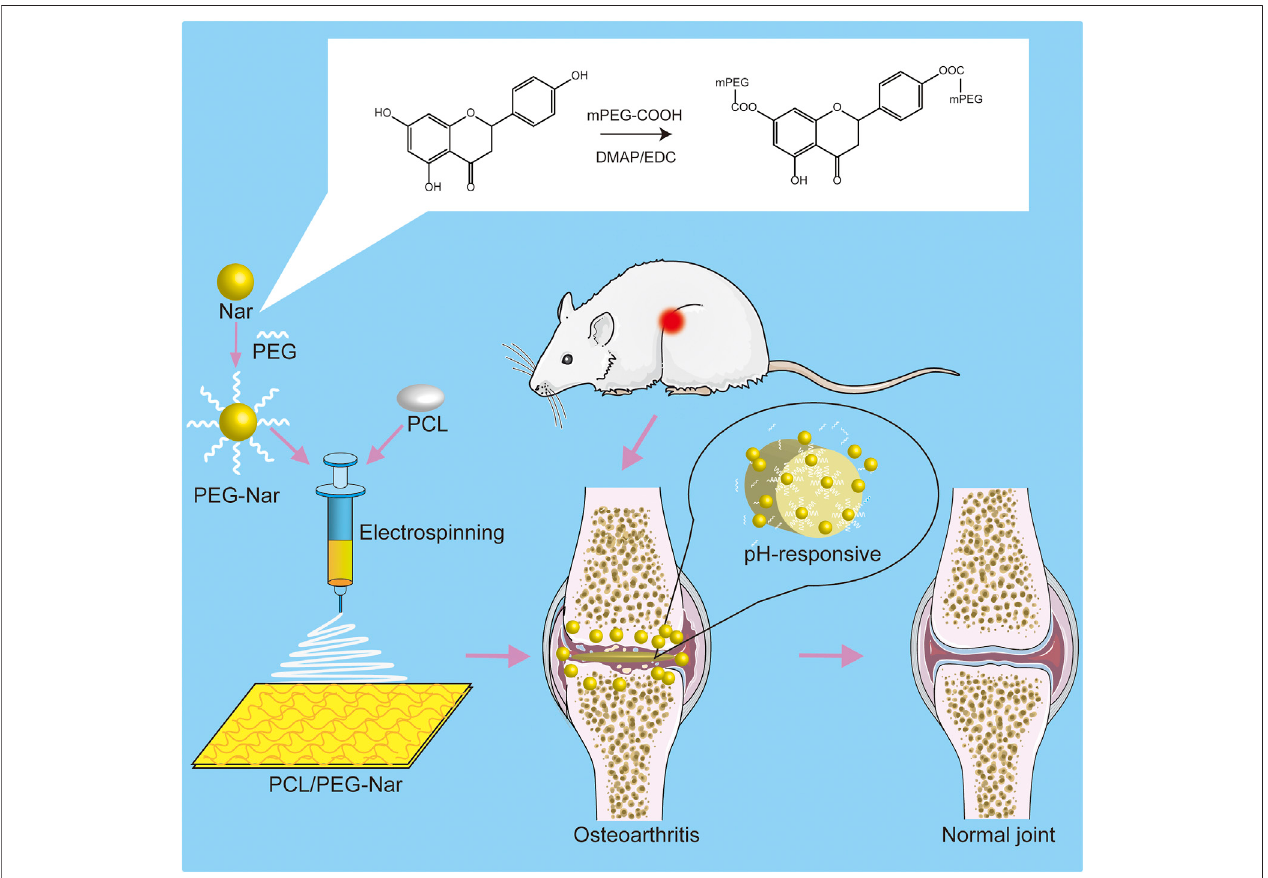
FIGURE 1 | Schematic diagram of PCL/PEG-Nar nano fi brous membrane preparation and its treatment in OA.